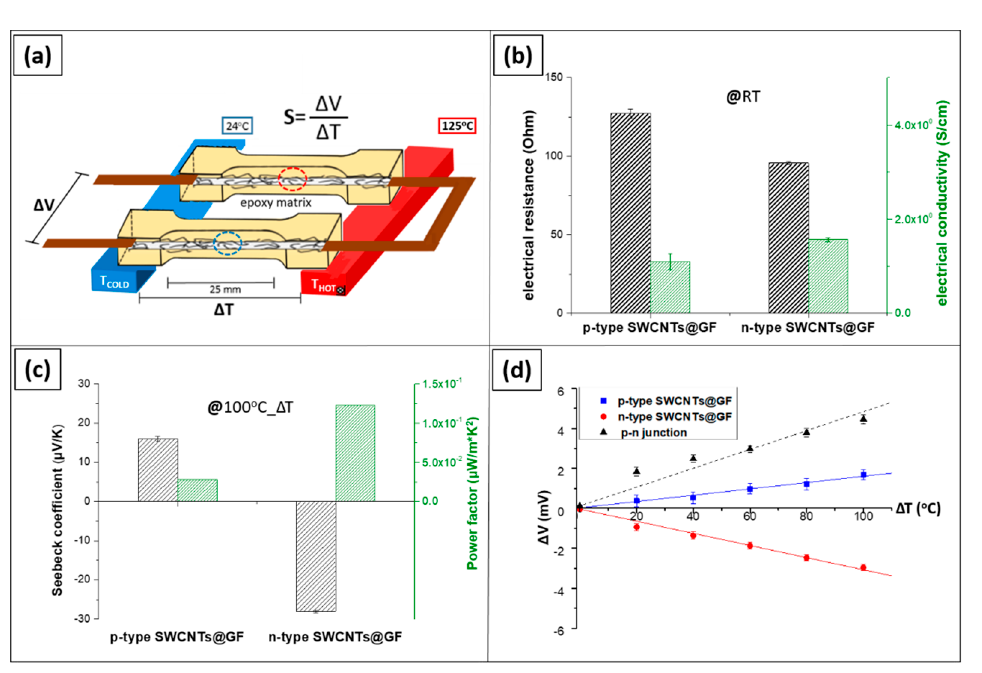
Figure 7. ( a ) schematic illustration of a p-n junction between the model composites created by interconnecting in series the p-type and the n-type model composites by a copper foil at the hot side (125 °C), while at the cold side (~24 °C) the copper electrodes were attached with the multimeter for a 2-probe measurement, graphs of ( b ) electrical resistance-electrical conductivity, ( c ) Seebeck coefficient-Power factor and ( d ) Δ V vs. Δ T curves for the coated p and n-type TE model composites.